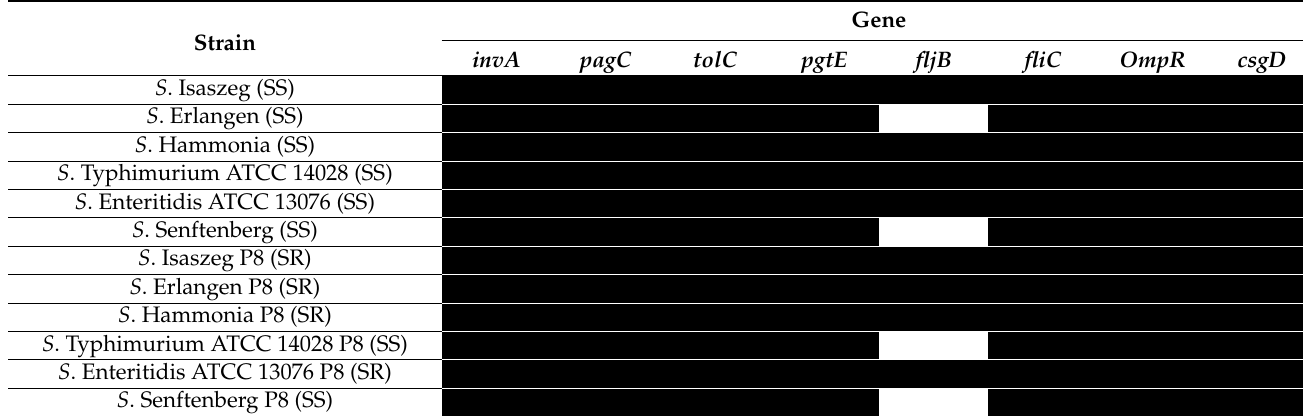
Table 3. Virulence genes (VGs) profiles of Salmonella enterica strains.